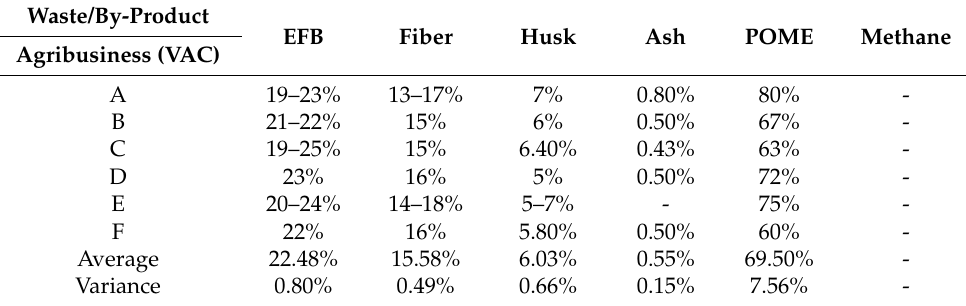
Table 5. Quantification of Values provided by the Agro-industries of the Casanare Department (VAC) of the waste and by-products derived from processing one ton of